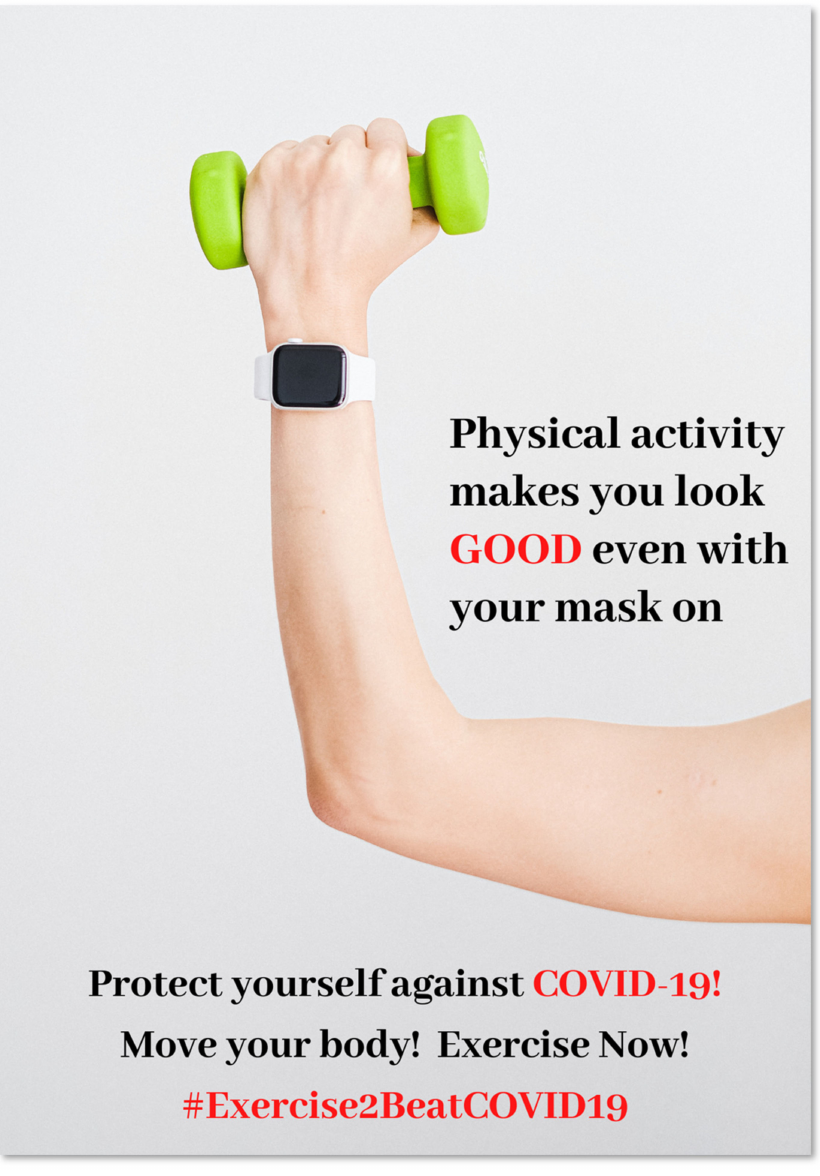
Figure 2. An example physical activity